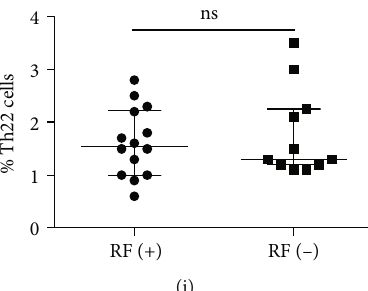
Figure 3: Association analysis between the levels of Th17 lymphocytes or Th22 cells and clinical parameters in RA patients. The correlation analysis between the percentages of pathogenic Th17 (pTh17) and Th22 cells (a), the percentage of pTh17 cells and time of evolution of disease (b), the percentage of pTh17 cells and the Disease Activity Score 28 (DAS28) (c), the percentage of Th22 cells and time of evolution of disease (f), or DAS28 (g) is shown. r and p values (Spearman sum rank test) are shown. The comparisons between the levels of pTh17 or Th22 cells in patients with low and high disease activity ((d) and (h), respectively), or with the presence or not of rheumatoid factor ((e) and (i), respectively), are also shown. Horizontal lines (in (d), (e), (h), and (i)) correspond to the median and Q 1 - Q 3 interquartile range. RF: rheumatoid factor; ns: nonsigni fi cant.